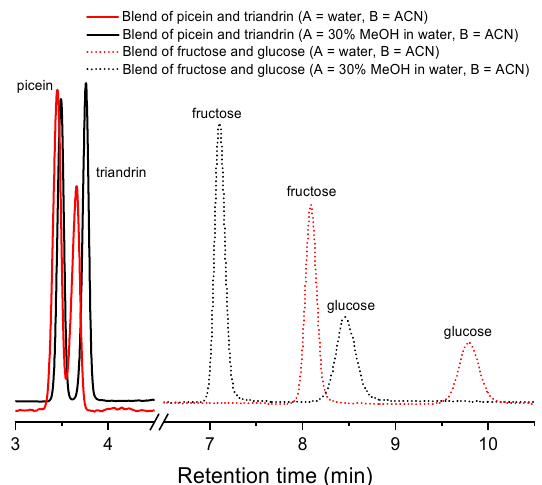
Figure 1. ELSD signals for picein ( t r = 3.45 and 3.49 min), triandrin ( t r = 3.66 and 3.77 min), fructose ( t r = 7.11 and 8.09 min), and glucose ( t r = 8.41 and 9.80 min) using the eluents: A = water, B = ACN (A/B = 17/83) and A = 30% MeOH in water, B = ACN (A/B = 20/80). The flow-rate was 1.3 mL/min and the injection volume 5 µ L. The use of MeOH in aqueous eluent clearly increased the resolution between the picein and triandrin, while the retention time of fructose and glucose decreased. The column used was Phenomenex Luna Omega Sugar (please see Materials and Methods section for further